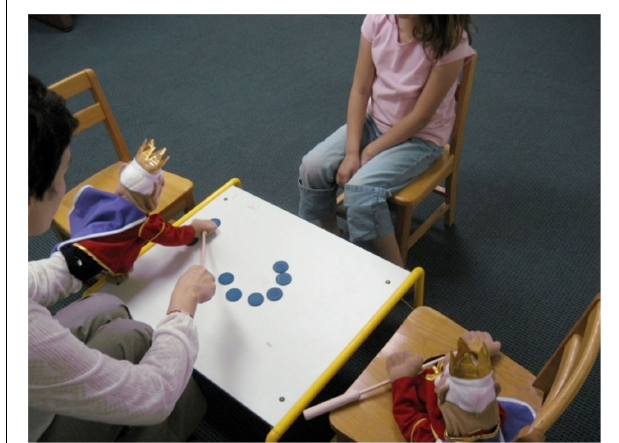
FIGURE 1 | Experimental situation in the United States. Identical puppets were animated in turn by the Experimenter during the three-way sharing game (here the “stingy” puppet maximizes coins for